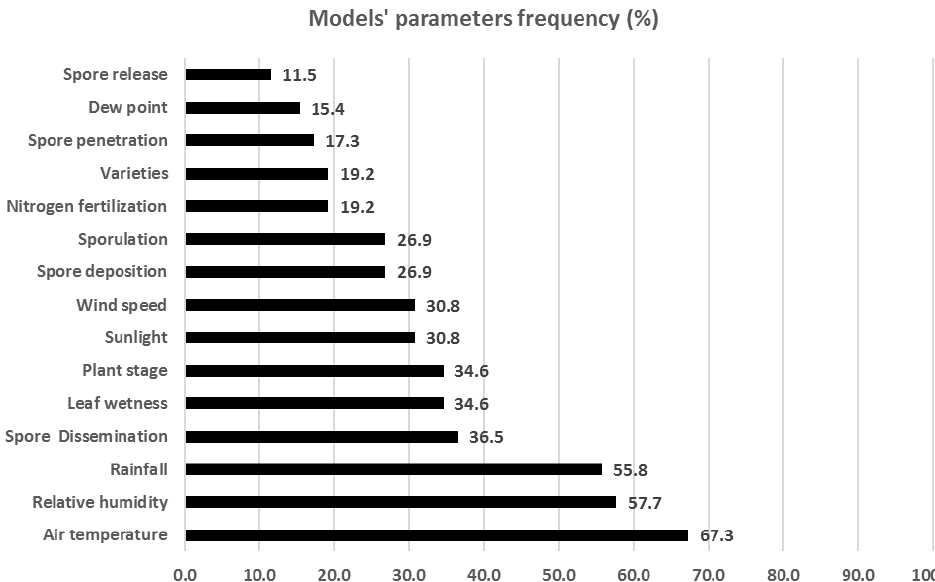
Figure 1. Frequency of different meteorological variables used in 52 rice blast forecasting